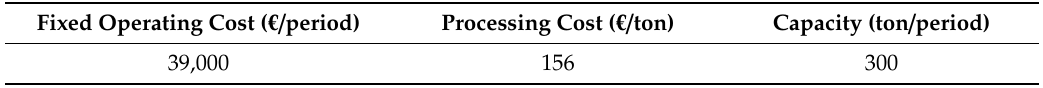
Table 2. Parameters of existing treatment centers.